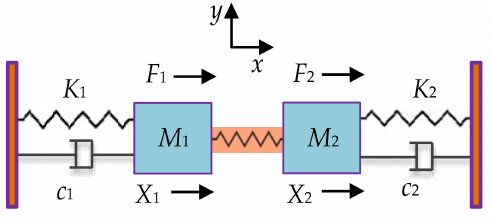
Figure 10. The lumped parameter model of a 2-DoF resonator.